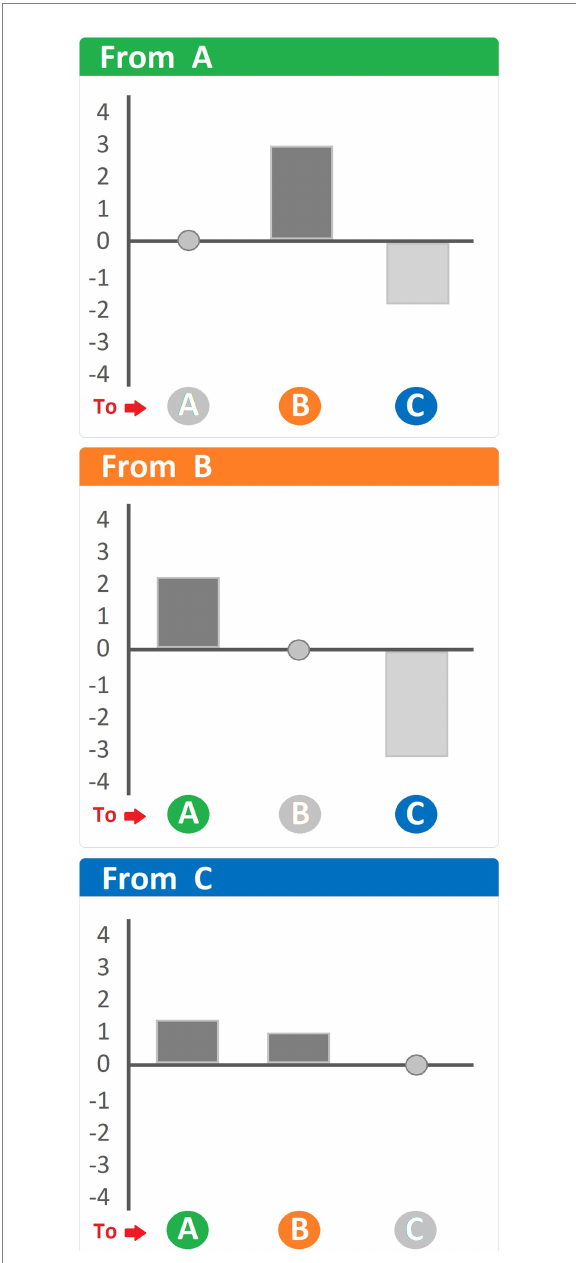
FIGURE 7 Hypothetical histogram of adjusted residuals representing the differences between observed and expected values. Heading of each panel: behavioral unit antecedent to the ones indicated at the bottom. Dark bars, positive residuals (i.e., transitions occurring more often than expected); light grey bars, negative residuals (i.e., transitions occurring less often than expected). See text for